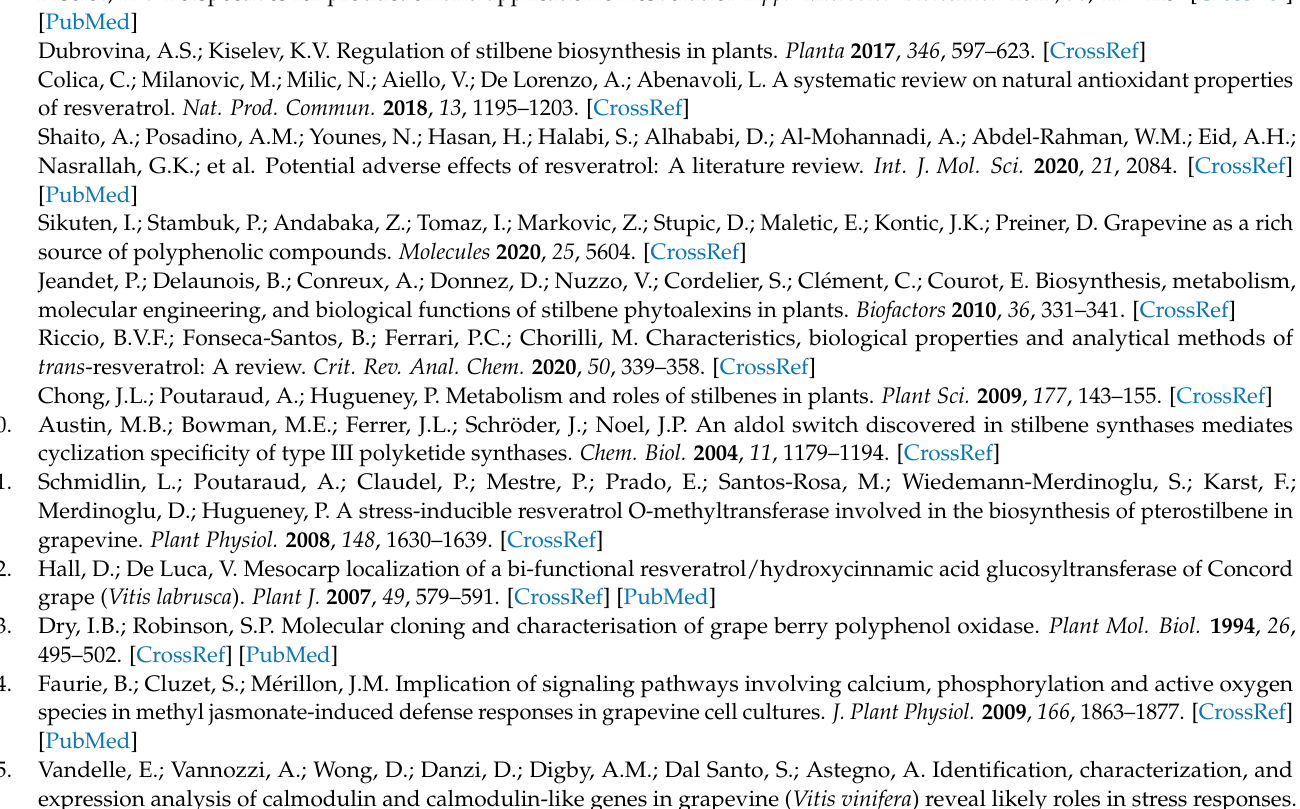
Figure S1: Vitis amurensis cell lines used in the experiments. Figure S2: HPLC chromatograms of anthocyanins in Vitis amurensis in control KA0 cell culture (A) and cell line 40-1 overexpressed VaMyb40 gene (detected at 530 nm). Figure S3: VaMyb40, VaMyb60, VvMyb40, and VvMyb60 genes sequences and primer design for PCR analysis. The colors of the primers match the primers shown in the supplementary table S1. Figure S4: Proposed model of the signaling pathway leading to stilbene biosynthesis induction and VaMyb40 and VaMyb60 functions in this process in the grapevine